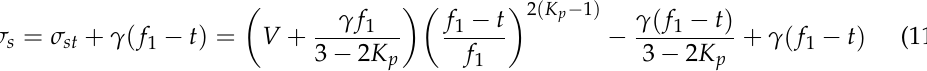
Figure 3. Stress analysis of soil inside primary arch.